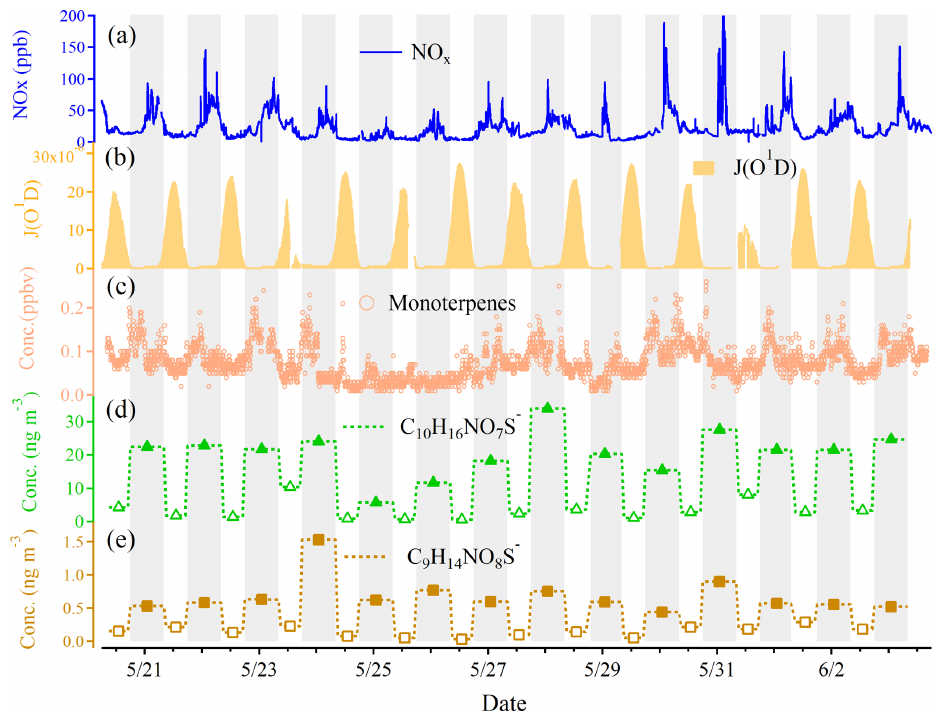
Figure 5. Time series of (a) NO x , ( b ) J(O 1 D), (c) monoterpene, (d) monoterpene NOSs (C 10 H 16 NO 7 S − ), and (e) limonaketone NOSs (C 9 H 14 NO 8 S − ). The gray background denotes the nighttime and the white background denotes the daytime.